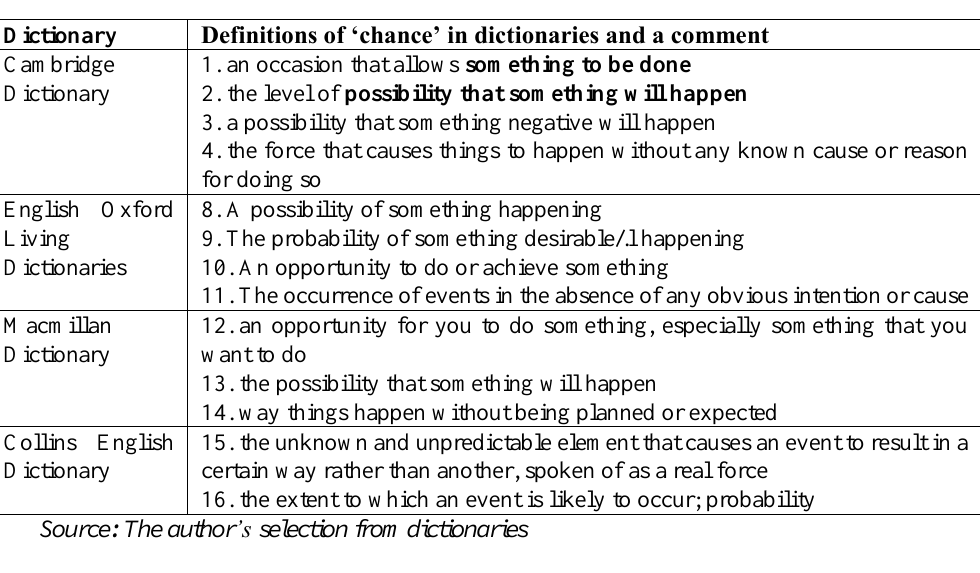
Table 4. Definitions of ‘chance’ from several